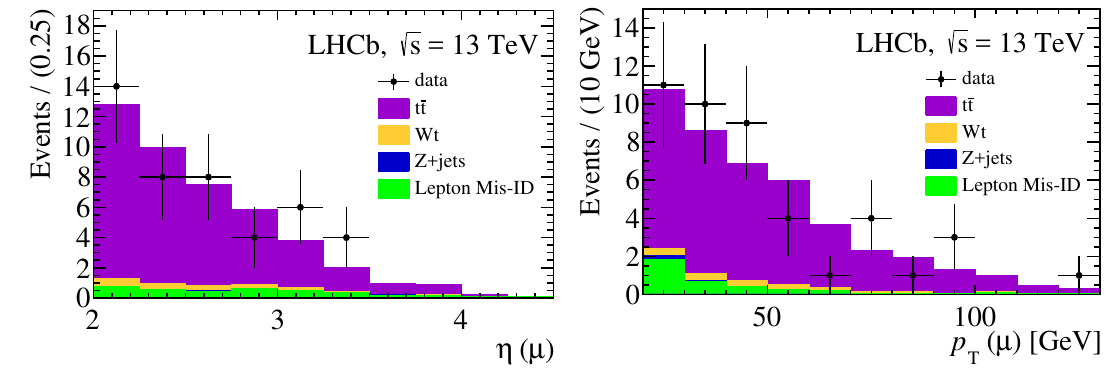
Figure 1 . The muon (left) (cid:17) and (right) p T distribution in data compared to the expected con- tributions. The tt signal yield is determined to be the number of selected events minus the sum of the expected backgrounds. The multiboson background is determined to be negligible.